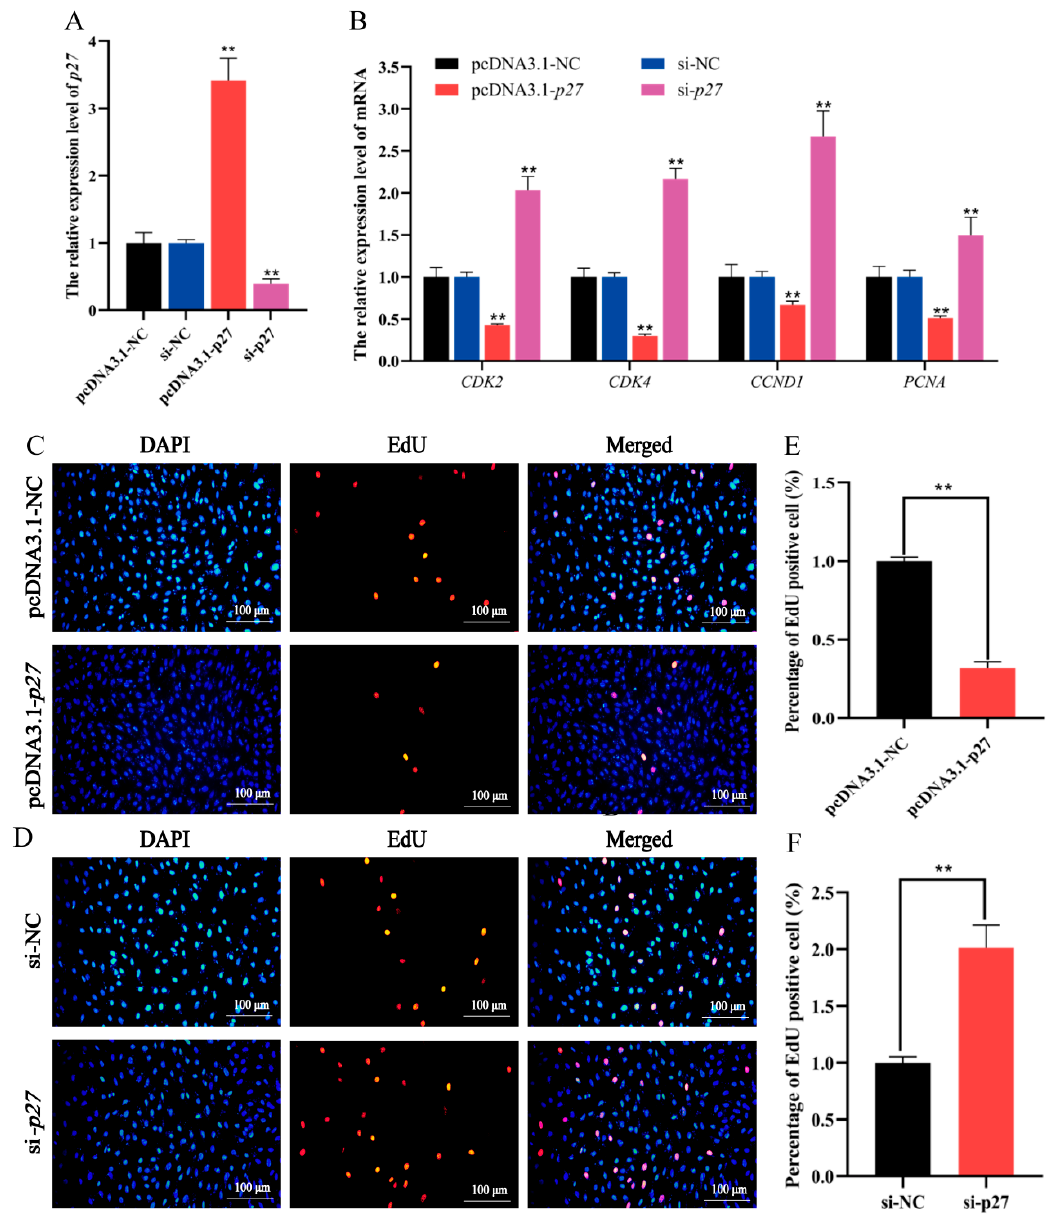
Figure 7. The effect of p27 on ovine preadipocyte proliferation when pcDNA3.1 ‐ p27 , si ‐ p27 and their NC groups were transfected into preadipocytes. ( A ) The expression level of p27 . ( B ) The expression levels of CDK2 , CDK4 , CCND1 and PCNA . ( C , D ) The EdU staining result. ( E , F ) The percentage of EdU positive preadipocytes counted by the ImageJ software. The values represent mean ± SD ( n = 3), ** p < 0.01.